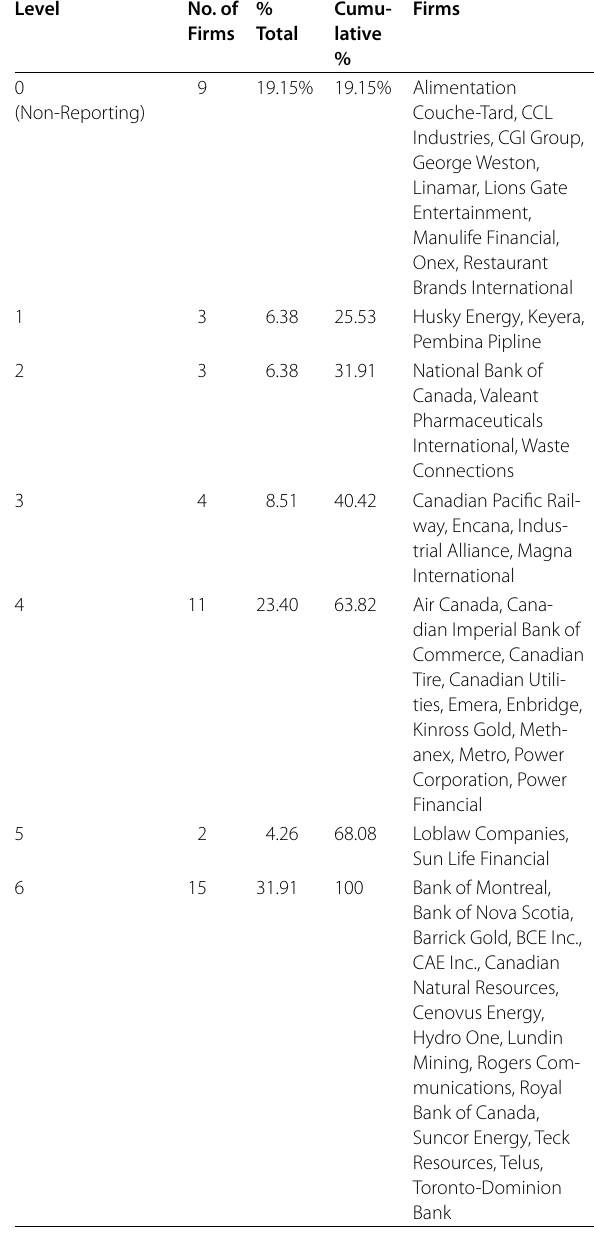
Table 1 Summary of Results (2018)